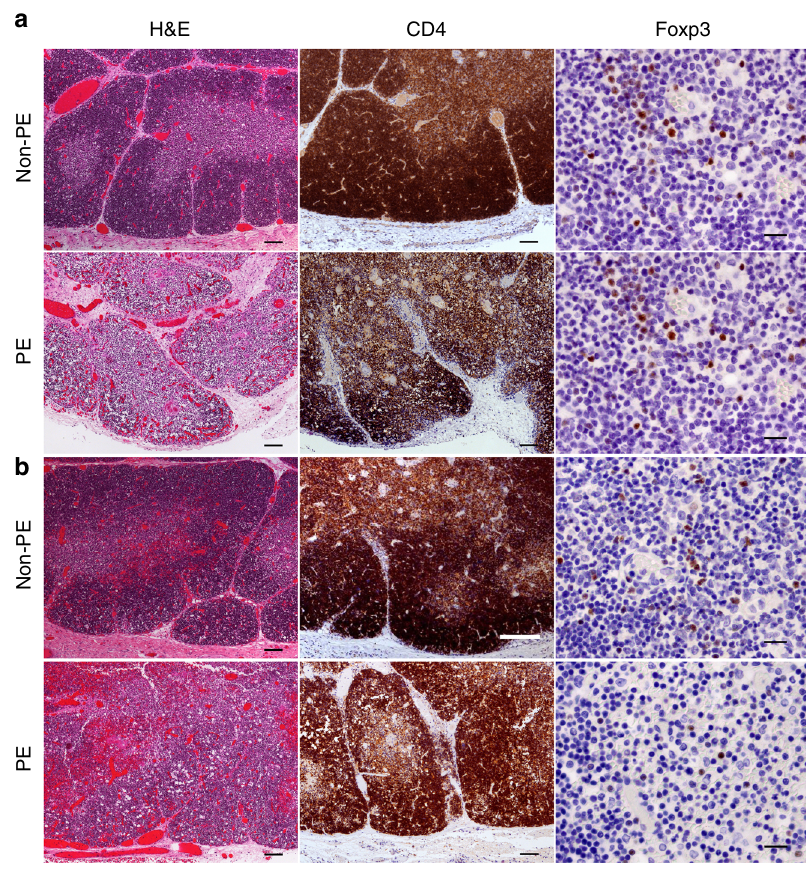
Fig. 4 Fetal thymus histopathology. Photomicrographs of fetal thymuses stained to compare CD4 + and Foxp3 + T-cell populations between the control group and those mothers with preeclampsia at the time of fetal demise. a Fetal thymuses of Control (upper panel) and preeclamptic mothers (lower panel), at 24 weeks gestation. b A 33-week-old control fetus (upper panel), versus a 37-week-old fetus deceased to a mother who had preeclampsia (lower panel). Scale bars for H&E stains and CD4 stains = 100 µ m. Scale bars for Foxp3 stains = 20 µ